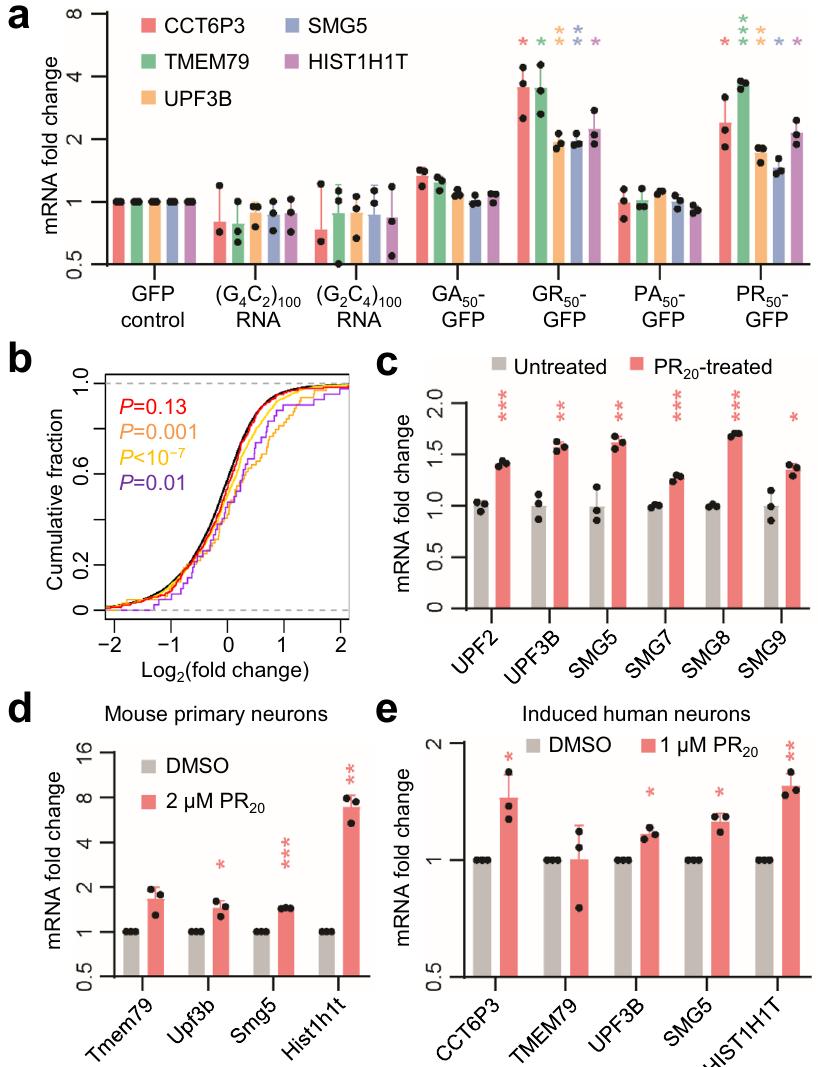
Fig. 2 R-DPRs inhibit UPF1-dependent RNA decay in cultured cells. a Changes in UPF1 target mRNA abundance in HEK293 cells ectopically expressing each repeat RNA or DPR. Expression levels relative to GAPDH were normalized to the GFP control. n = 3 independent experiments. b CDFs of changes in abundance for all mRNAs (black), NMD targets identi fi ed in Johnson et al. ( N = 275, red), Tani et al. ( N = 76, orange), in Colombo et al. ( N = 1271, yellow), and canonical histone mRNAs (purple), comparing between PR20-treated and control K562 cells. P values, two-sided Mann – Whitney U tests. c Changes in NMD factor mRNA abundance between control ( n = 3) and PR 20 -treated ( n = 3) K562 cells. Data are presented as mean values± SD. * P < 0.05; ** P < 0.01; *** P < 0.001, two-sided unpaired t tests. d Changes in abundance of UPF1 target mRNA orthologs in 2 μ M PR 20 -treated mouse primary neurons. n = 3 independent experiments. e Change in UPF1 target abundance in 1 μ M PR 20 -treated human iNeurons. n = 3 independent experiments. a , d , e Data are presented as mean values ± SD. * P < 0.05; ** P < 0.01; *** P < 0.001, two-sided ratio t tests. Source data and exact P values are provided in the Source Data fi